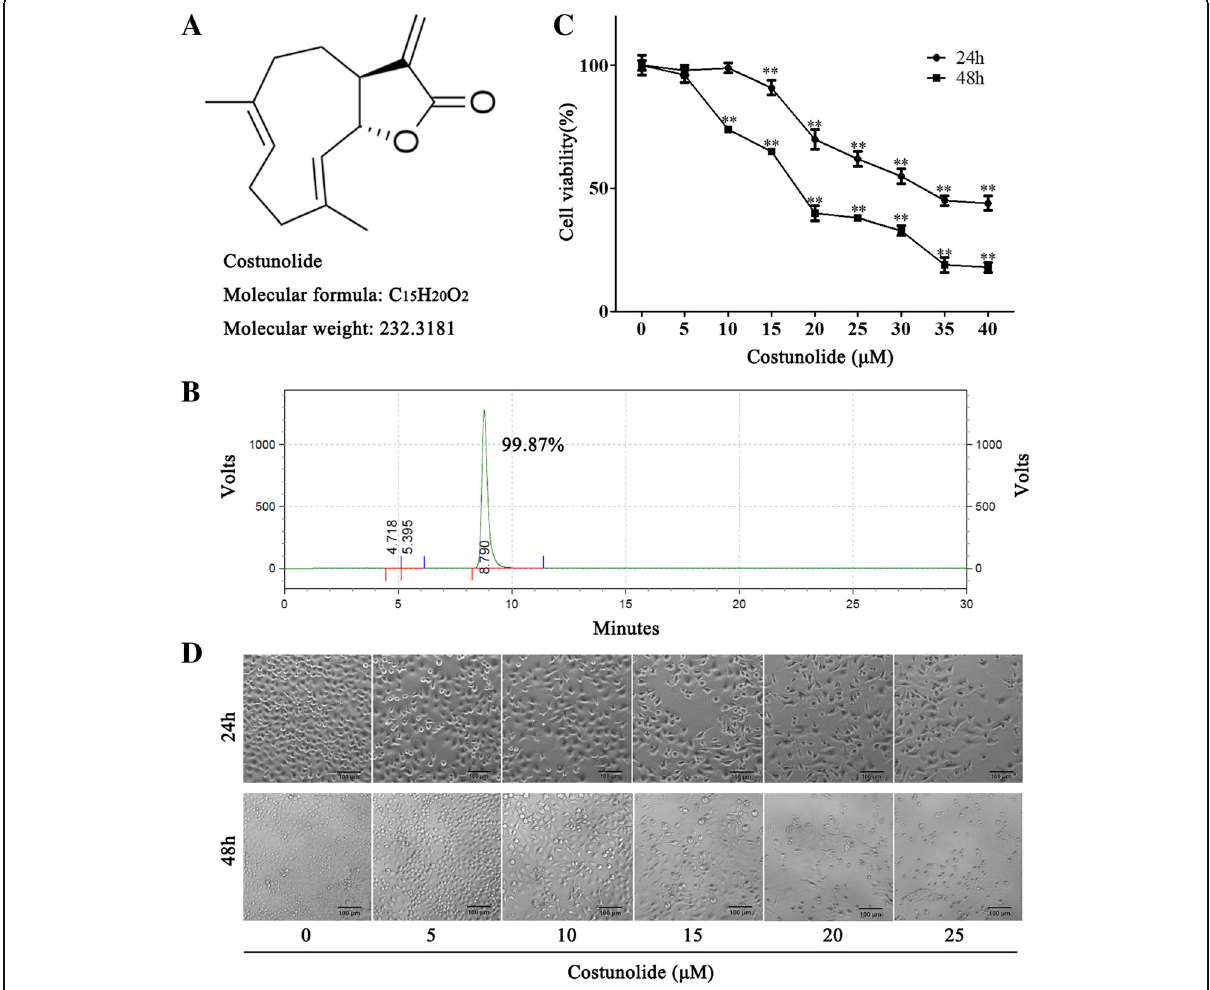
Fig. 1 Costunolide inhibited the viability of gastric adenocarcinoma BGC-823 cells. a Chemical structure of costunolide. Molecular formula: C 15 H 20 O 2 , molecular weight: 232.32, CAS No.: 553 – 21-9. b Purity of costunolide detected by HPLC. The purity is 99.87%. c The viability of BGC-823 cells treated by costunolide with different concentration (0, 5, 10, 15, 20, 25, 30, 35 and 40 μ M) for 24 and 48 h is detected by MTT assay. d The morphology of BGC-823 cells treated by costunolide with different concentration (0, 5, 10, 15, 20 and 25 μ M) for 24 and 48 h is observed by light inverted microscopy (magnification: 100×, bar in the picture represents 100 μ m). Compared to control group, * P < 0.05, ** P <